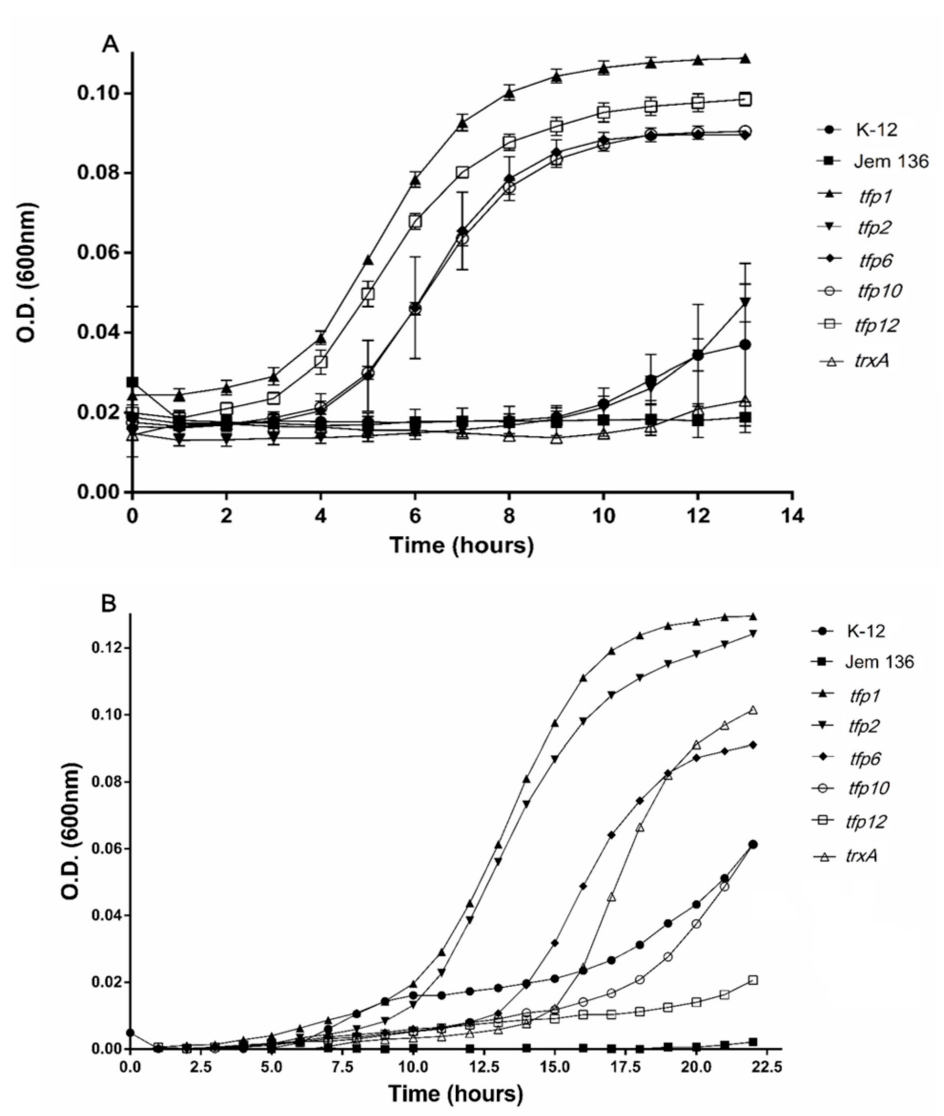
Figure 3. Growth of Escherichia coli JEM-136 complemented with tfp genes under oxidative stress culture conditions. Expression induction of the tfp gene in E. coli carrying pBADTopo- tfp was carried out with l -arabinose, as described in Materials and Methods. The complemented strain was grown on minimum tryptone yeast extract salts (TYES) medium under stress conditions with 0.5 mM (Fe 2 (SO 4 ) 3 ) ( A ) for 15 min, then transferred to a fresh medium, and grown for another 13 h. For diamide stress, the cells were exposed to 0.4 mM diamide and then grown for 20 h ( B ).